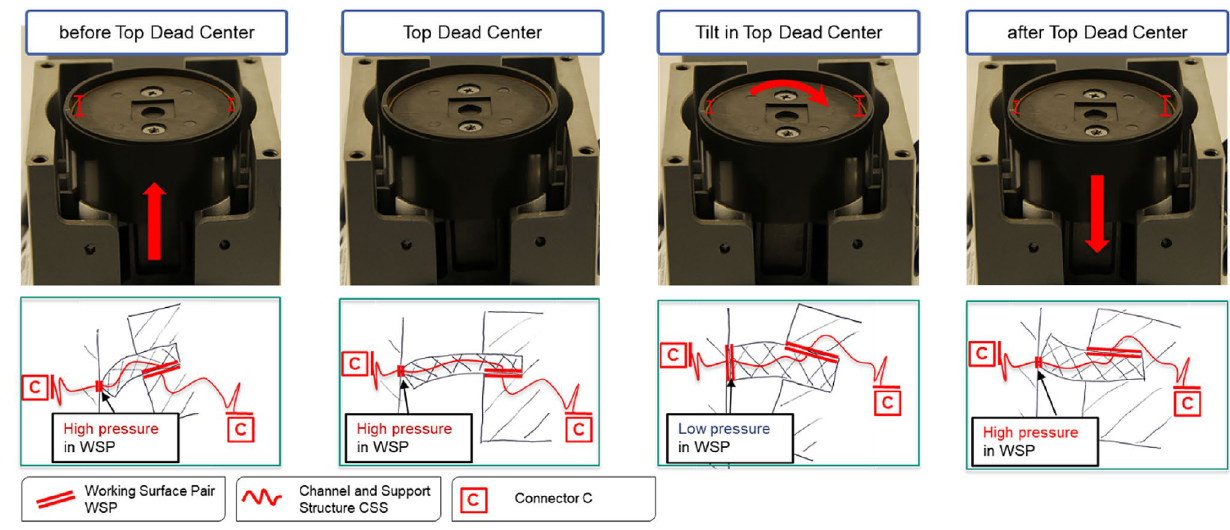
Fig. 13 C&C 2 -Sequence Model of the piston